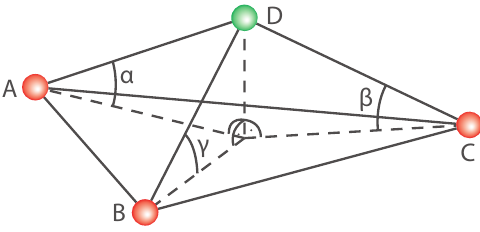
Figure 3. Sketch of the applied progressive TIN densification filter, modified after Axelsson (2000).